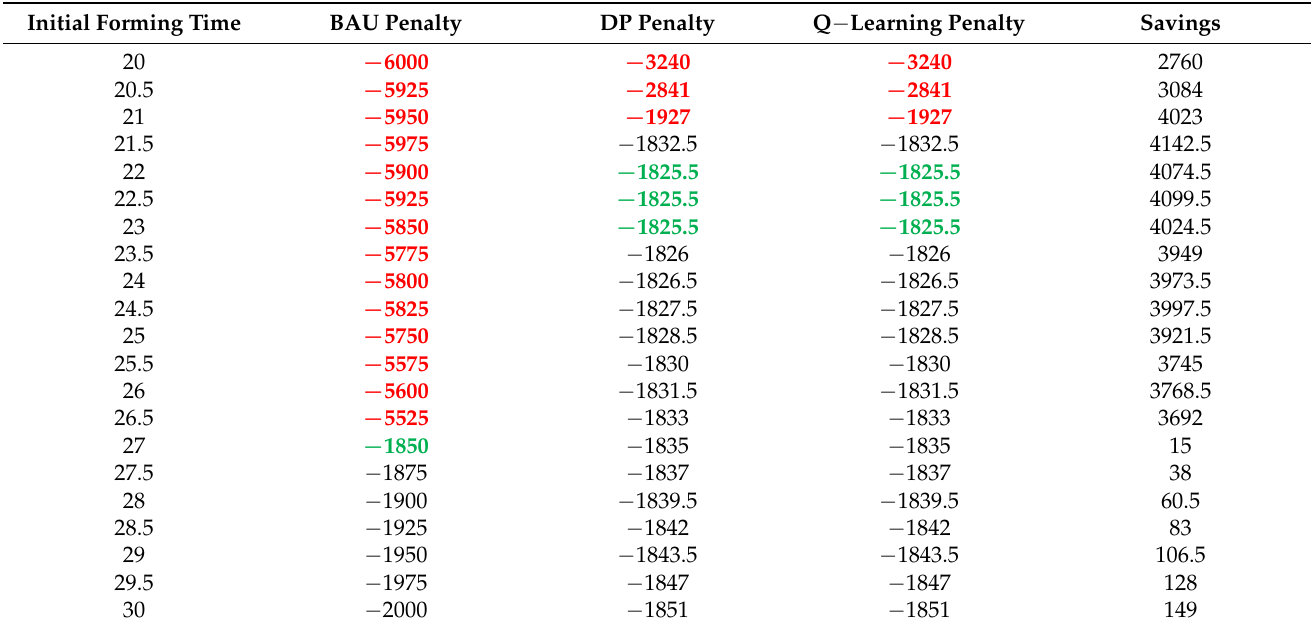
Table 8. Batch penalty production for all the experiments with the BAU, DP, and Q-Learning policies. A non-feasible solution is marked in red, and the best solutions within each policy are marked in